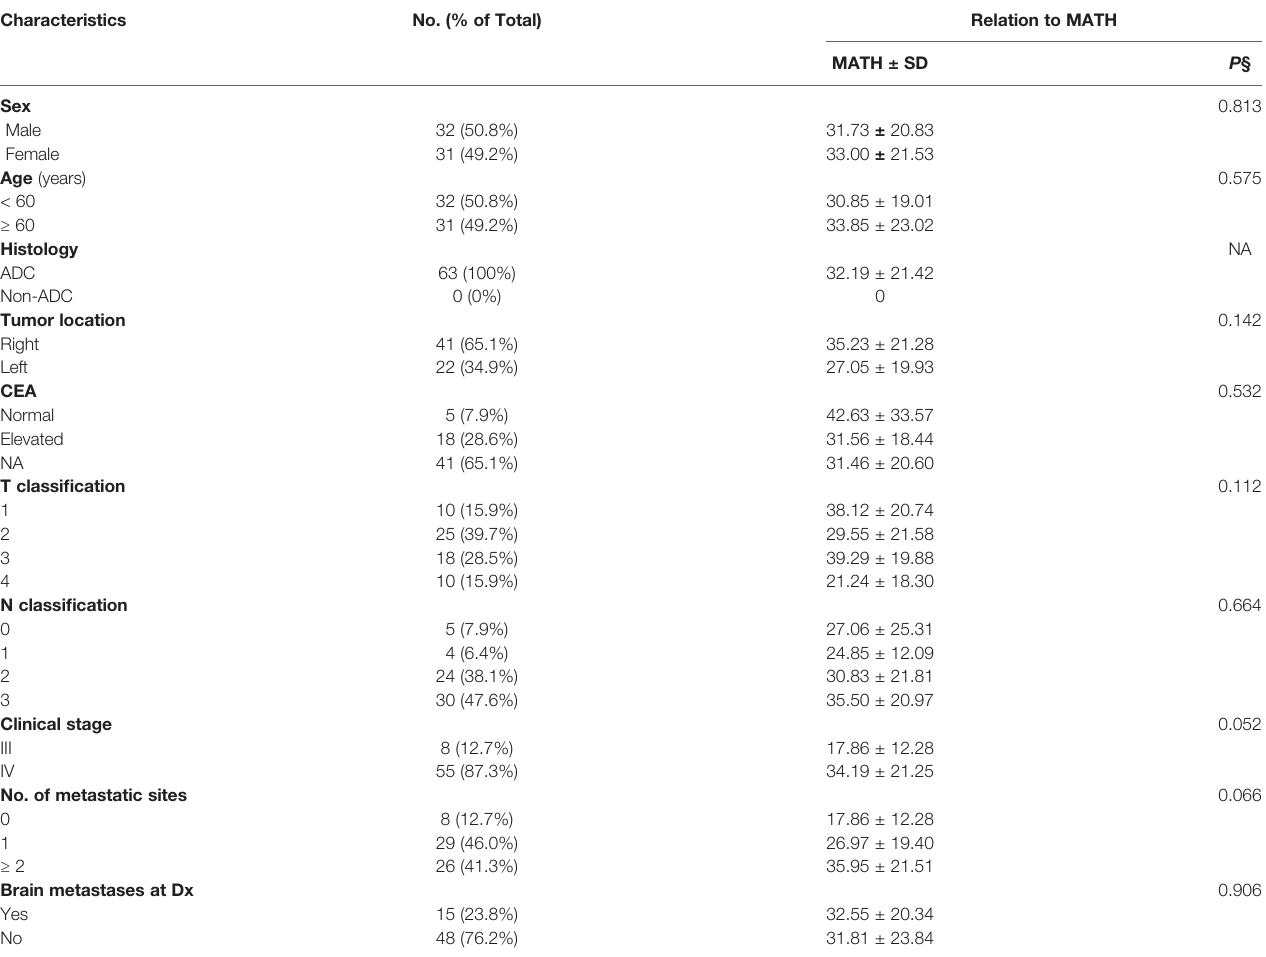
TABLE 1 | Association of clinical characteristics with MATH. Characteristics